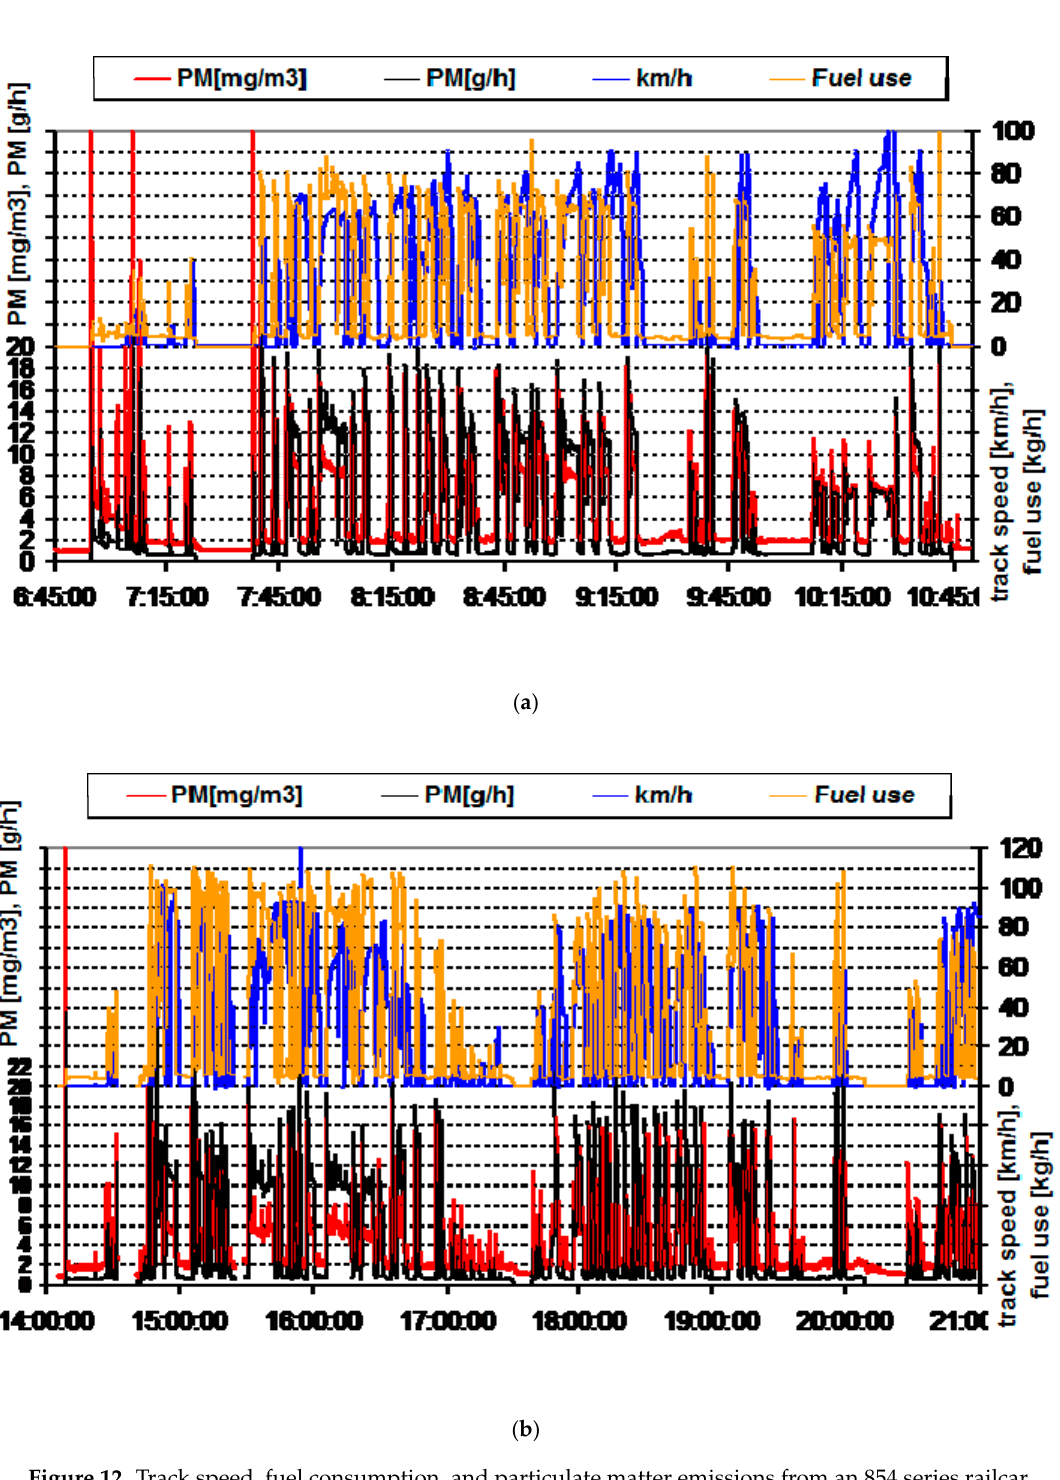
Figure 12. Track speed, fuel consumption, and particulate matter emissions from an 854 series railcar during ( a ) morning and ( b ) afternoon service on local and express trains on the Praha – Turnov line.